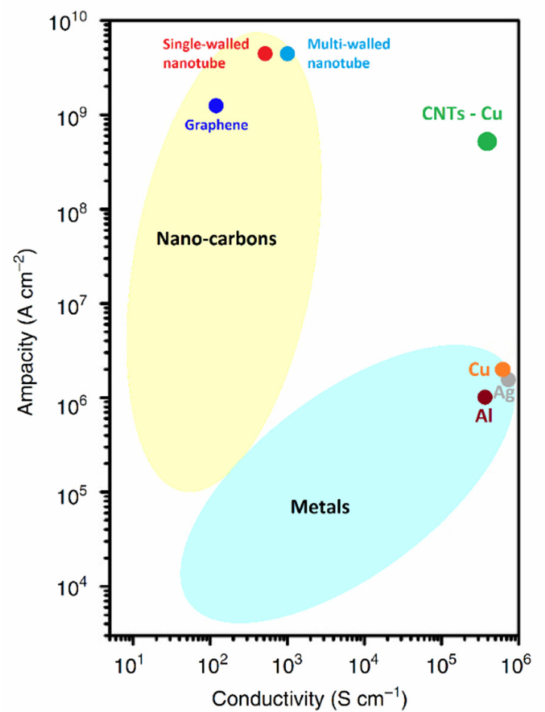
Figure 5. Current carrying capacity as a function of the electrical conductivity of different conducting materials